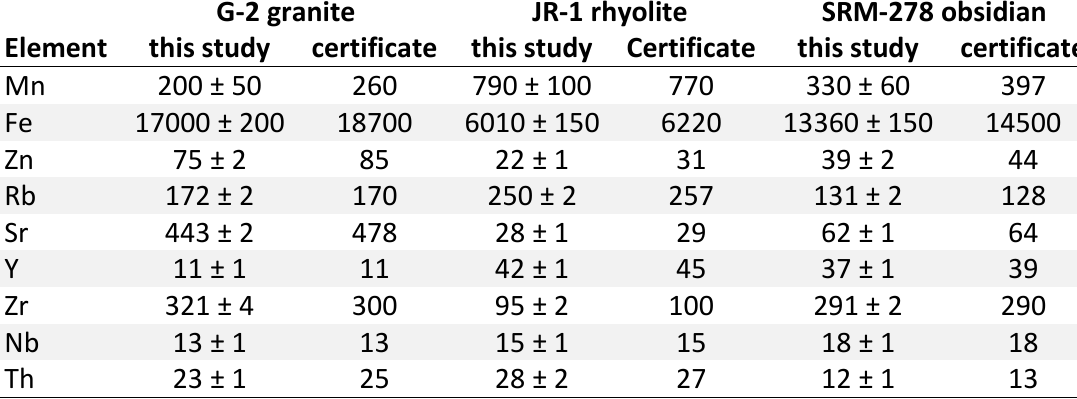
Table 2. Concentrations in ppm for international rock standards measured in this study compared to their certificate values. G-2 is from the US. Geological Survey; JR-1 is from the Geological Survey of Japan; SRM- 278 is from the National Institute of Standards and